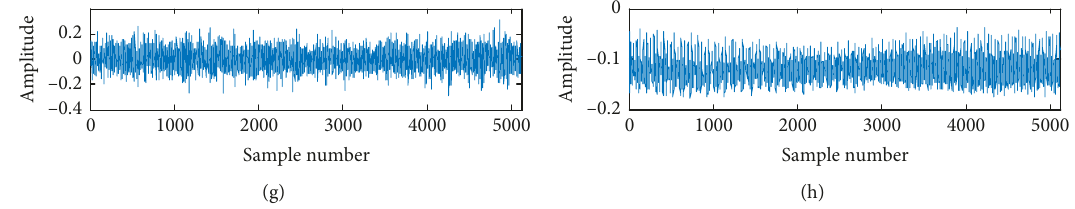
Figure 18: Multiresolution DMD modes of roller bearing’s inner race fault signal (NASA, snapshots 2003.11.22.11.06.56).